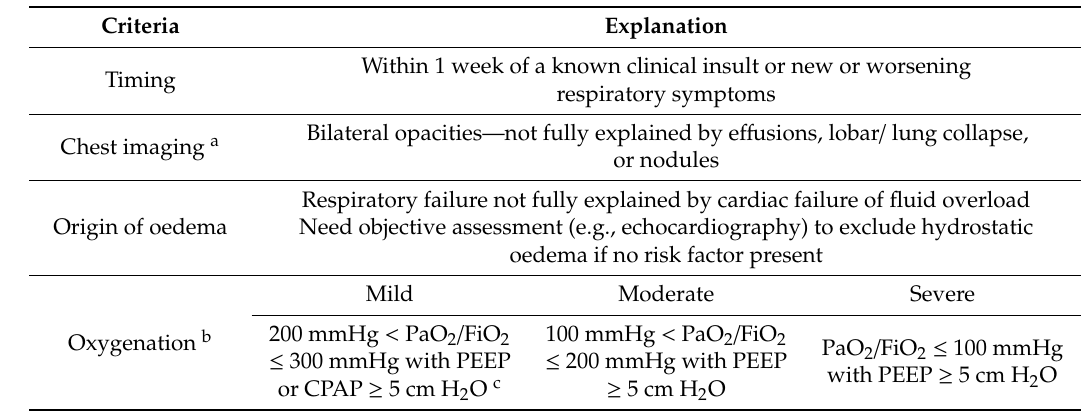
Table 2. Berlin Definition of ARDS. Adapted from Ranieri et al. [44].